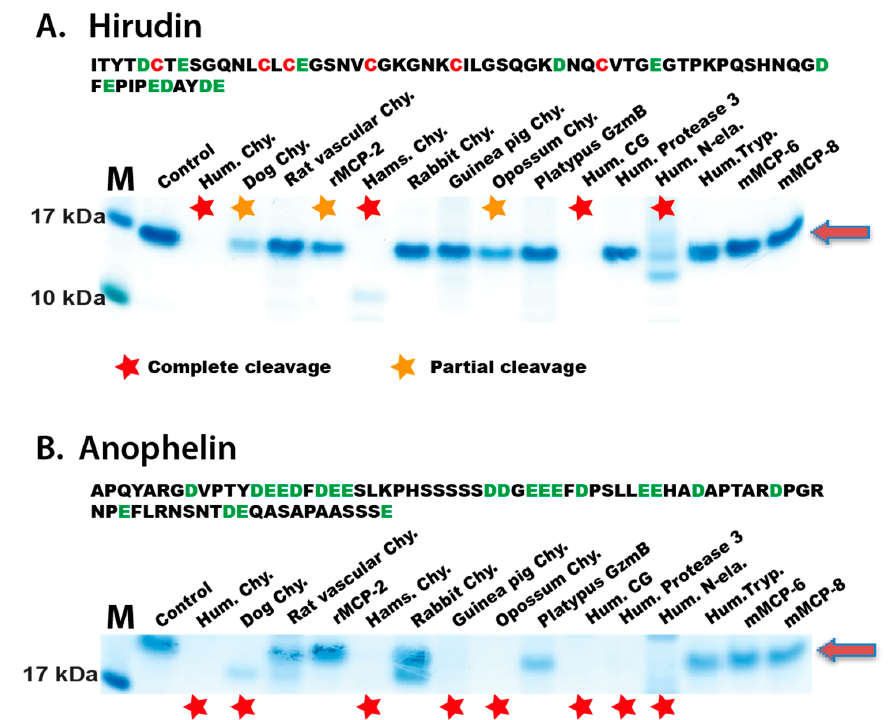
Figure 2. Cleavage of the anticoagulant proteins, hirudin and anophelin, by a panel of mammalian hematopoietic serine proteases . The efficiency in cleavage of three anticoagulant proteins were assayed in a 15 µL sample volume with approximately 1 µg of the anticoagulant protein and varying amount of protease depending on the activity as determined previously. All proteases except mMCP-8 have been described in previous publications (Human chymase [30], Dog chy- mase [31], rMCP-1 [32], Rat vascular chymase (RVC) [33], rMCP-2 [34], Hamster chymase [35], Rabbit and Guinea pig Leu-ases [29], Opossum chymase [36], Platypus chymases [37], Human cathepsin G [38], Human proteinase 3 and N-elastase [39], Human mast cell tryptase and mMCP-6 [40]. Panel ( A ) shows the amino acid sequence of hirudin where the cysteines have been marked in red and all negatively charged residues in green. Below the amino acid sequence, the cleavage reactions are presented for the panel of hematopoietic serine proteases. A red arrow marks the position of the hirudin protein on the gel. Panel ( B ) shows the amino acid sequence of anophelin where all negatively charged residues are in green. Anophelin contains no cysteines. Below the amino acid sequence, the cleavage reactions are presented for the panel of hematopoietic serine proteases. A red arrow marks the position of the anophelin protein. Red stars mark complete cleavage and orange stars partial